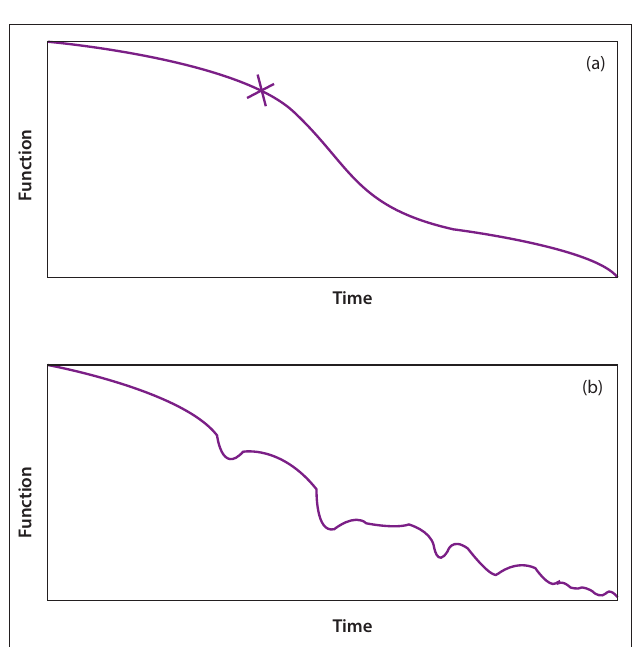
Fig. 2. Course of (a) Alzheimer’s disease and (b) vascular dementia.